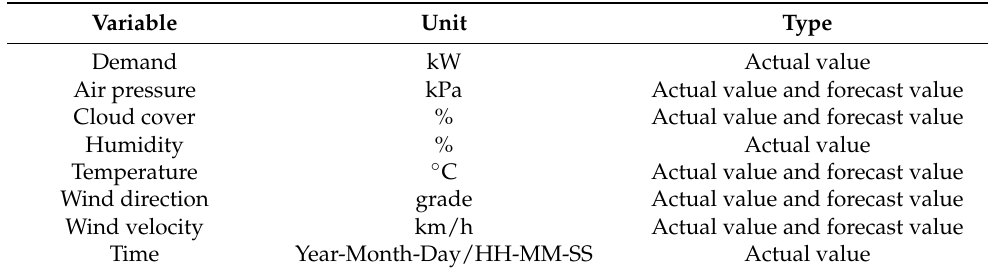
Table 2. Database Variables of the “IEEE Dataport Competition Day-Ahead Electricity Demand Forecasting: Post-COVID